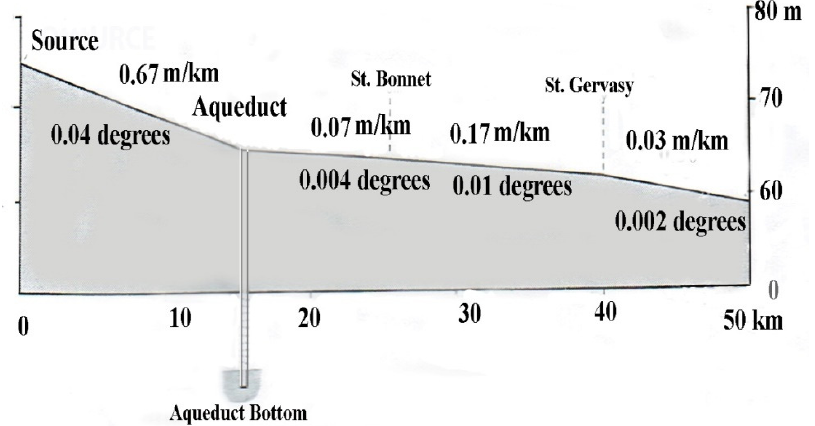
Figure 7. Average slopes of sections of the Pont du Gard aqueduct in m/km and equivalently in degrees.